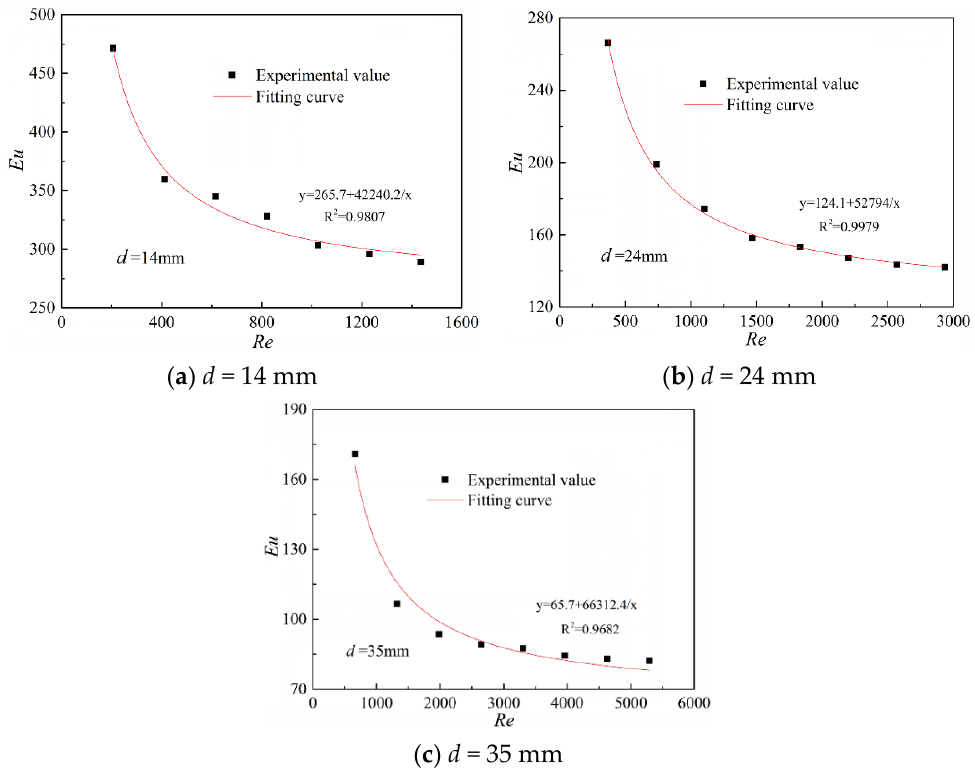
Figure 4. Relationships of Eu with Re under different particle diameters.